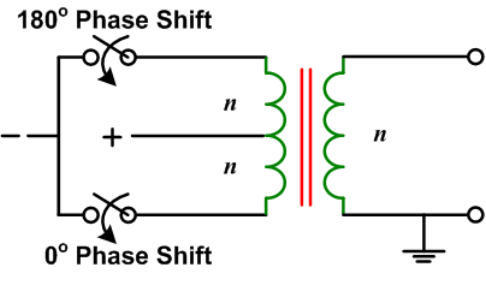
Figure 5. Isolation transformer used to create 180° phase shifts